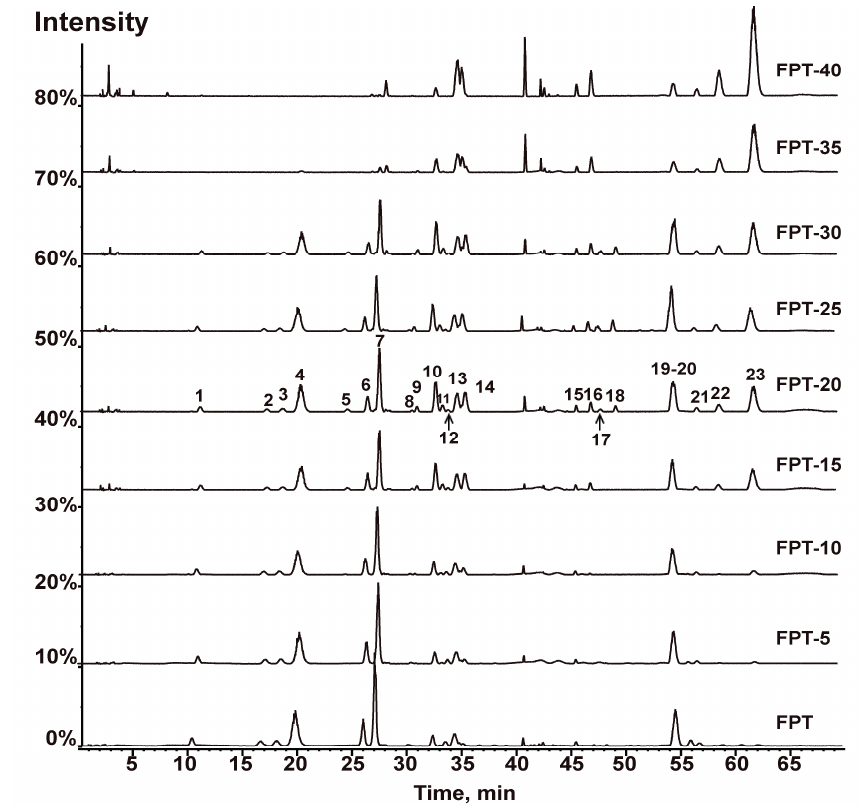
Figure 2. The representative BPC of FPT-N samples based on HPLC-MS/MS. Flavonoids extract in Pollen Typhae (FPT) was heated for 5 min (FPT-5), 10 min (FPT-10), 15 min (FPT-15), 20 (FPT-20), 25 min (FPT-25), 30 min (FPT-30), 35 min (FPT-35), 40 min